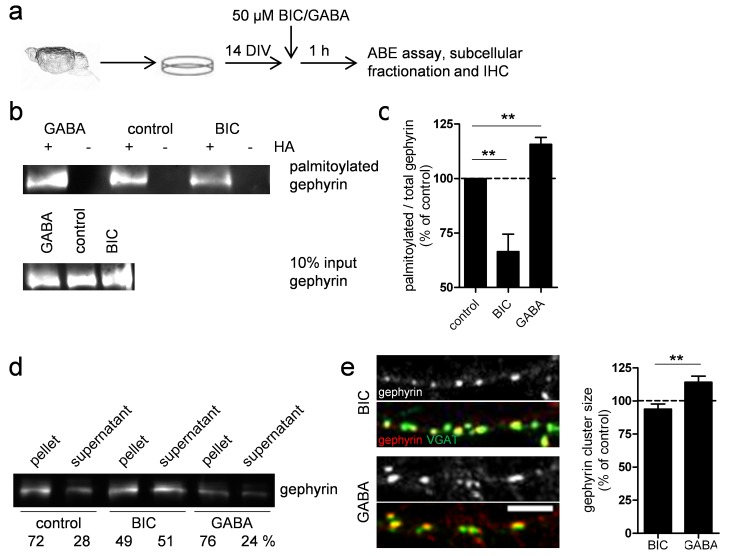
Gephyrin palmitoylation is regulated by GABAAR-activity.(a–e) Primary hippocampal neurons were cultured 14 DIV and exposed to 50 µM bicuculline (BIC) or GABA for 1 h. (b) Representative Western blot shows altered gephyrin palmitoylation in the presence of BIC and GABA. (c) Quantification of gephyrin palmitoylation in neurons treated as in (a). Palmitoylation was normalized to total levels of gephyrin (n = 3). (d) Representative immunoblot of subcellular fractionation of neurons after treatment as in (a). (e) Representative immunostaining of gephyrin and VGAT. Scale bar, 5 µm. Histogram showing quantification of gephyrin cluster size after exposure to bicuculline or GABA compared to control cultures (see a) from three independent cultures. All data are means ± SEM (**p<0.01 using Student's t test).